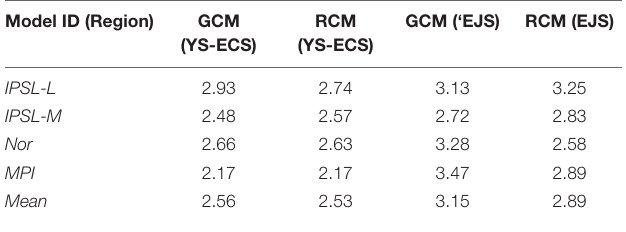
TABLE 2 | The root mean square error (RMSE; units: ◦ C) between the satellite-derived SST and modeled SST in the shallow (YS-ECS) and deep seas